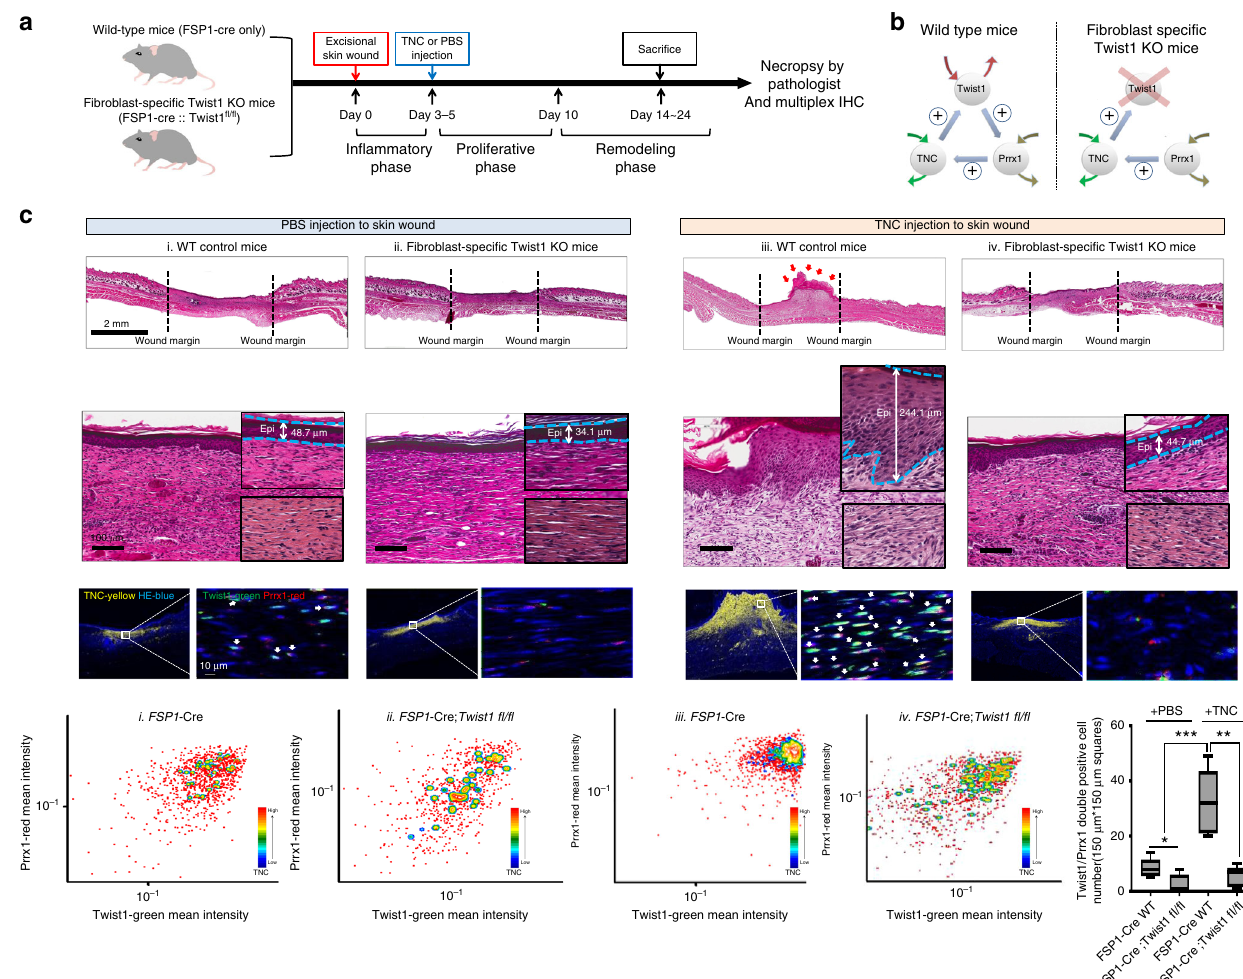
Fig. 6 Sustained switching ON of the Twist1-Prrx1-TNC PFL triggers persistent fi broblast activation, forming fi brotic nodules in vivo during wound healing. a Schematic diagram of the experimental design. We injected TNC protein or PBS (control) into the wound area of WT and fi broblast-speci fi c Twist1 knockout mice. The experiments were conducted three times ( N = 5 mice in each experimental group). Experimental timeline for the detailed procedures is indicated. b The maintenance of the PFL activation by TNC injection (FSP1-cre; Twist1 WT mice, left) and disruption of PFL by fi broblast-speci fi c Twist1 de fi ciency despite the TNC injection (FSP1- Cre;Twist1 fl / fl mice, right). c H&E staining images showing the wound areas of each group (top). In Twist1 WT mice (depicted as iii, FSP1-cre; Twist1 WT), we observed fi broblastic nodules (red arrow) comprising hyper-proliferative immature fi broblasts and epithelial cell hyperplasia (blue dotted line). TNC is strongly expressed in most fi broblastic nodules as mentioned above in which Twist1 and Prrx1 are also strongly coexpressed. These results were obtained through multiplex IHC staining and visualized using ImageJ Fiji (Twist1-green, Prrx1-red, TNC-yellow, and hematoxylin-blue). We performed quantitative analysis of these results using FCS Express 6 image cytometry analysis software, and we presented the outcomes as an FACS plot ( x axis-Twist1 green, y axis-Prrx1 red and contour indicated with TNC) (bottom). The number of fi broblasts displaying